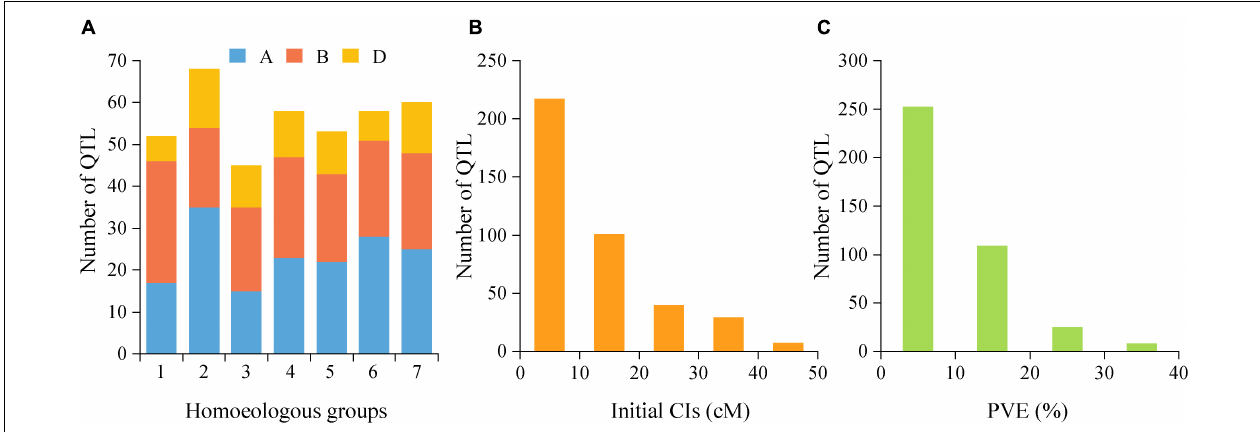
FIGURE 3 | (A) Number of QTLs on seven homoeologous groups (1-7) and three sub-genomes (A,B,D) from the collected QTL studies. (B) supporting intervals estimated from the initial QTLs. (C) the individual PVE from QTLs. PVE, phenotypic variance explained.